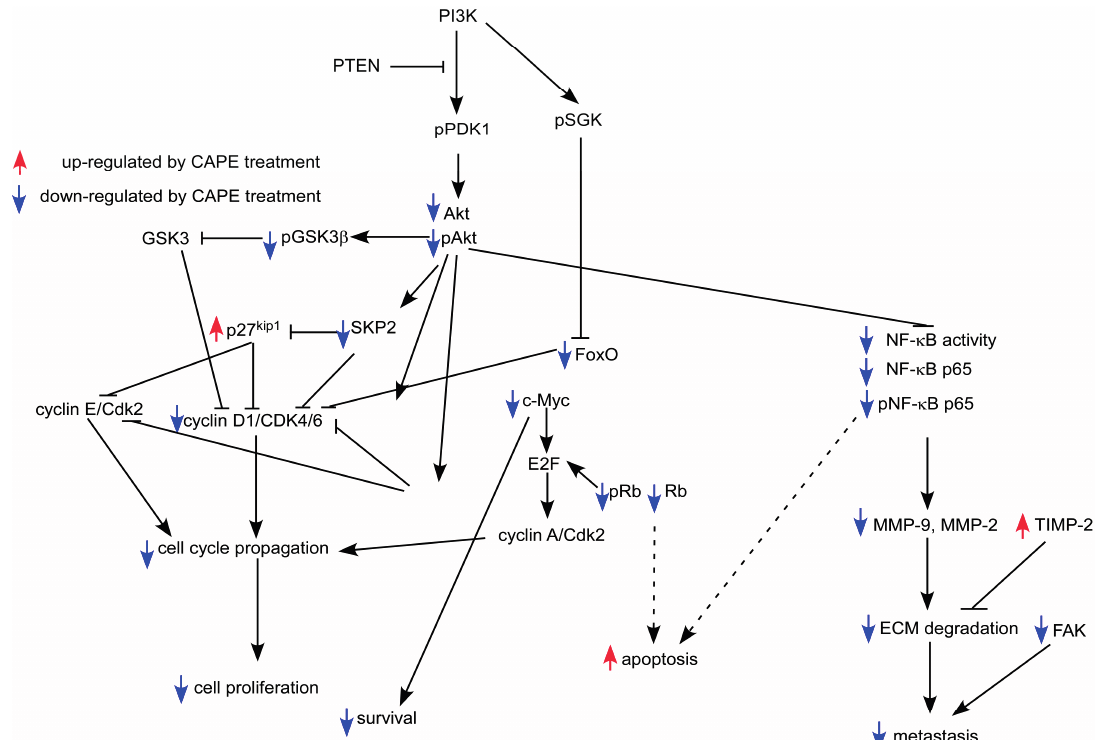
Figure 2. Putative model of anti-cancer effect of CAPE in human oral cancer cells. Protein abundance or activity being stimulated by CAPE treatment are labeled with red upward arrows, while those being suppressed by CAPE treatment are labeled with blue downward arrows. Arrows indicate activation of downstream signaling proteins, while bars mean inhibition of downstream signaling proteins. Dash lines indicated possible